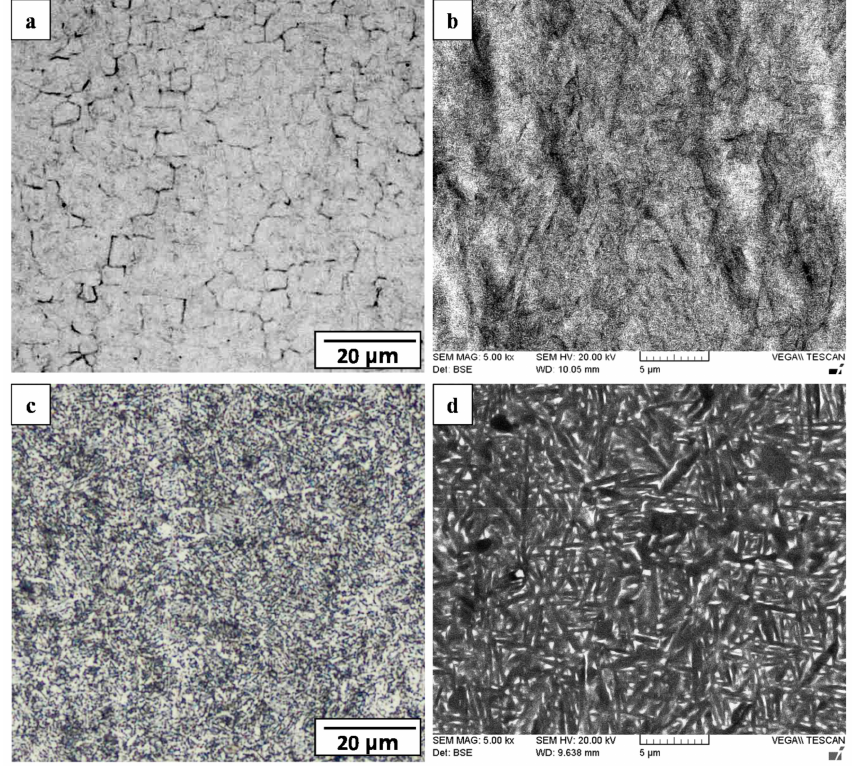
Figure 7. WC microstructure in Ti-6242 welds: ( a , b ) AWed (OM and SEM) ( c , d ) SRAed (OM and